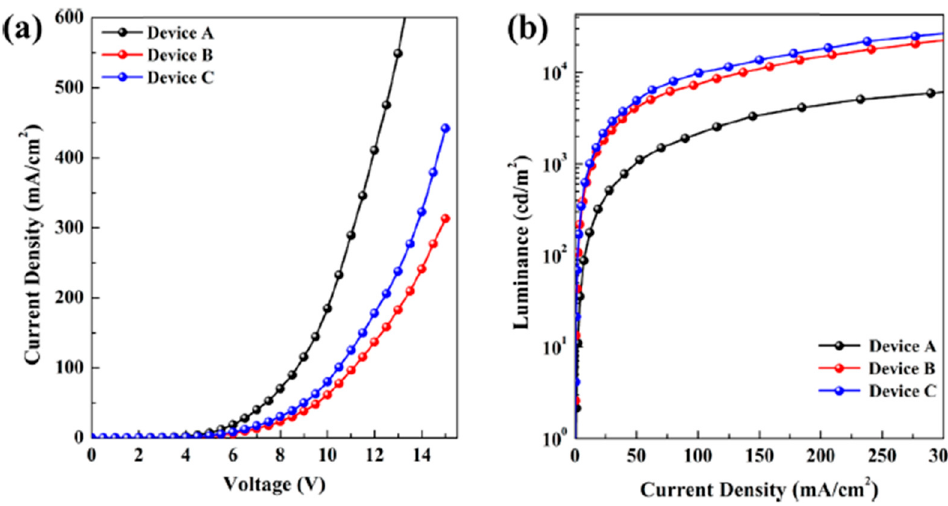
Figure 21. ( a ) J-V and ( b ) J-L characteristics of the OLEDs. Reproduced [156] with permission from. Copyright American Chemical Society, 2020.